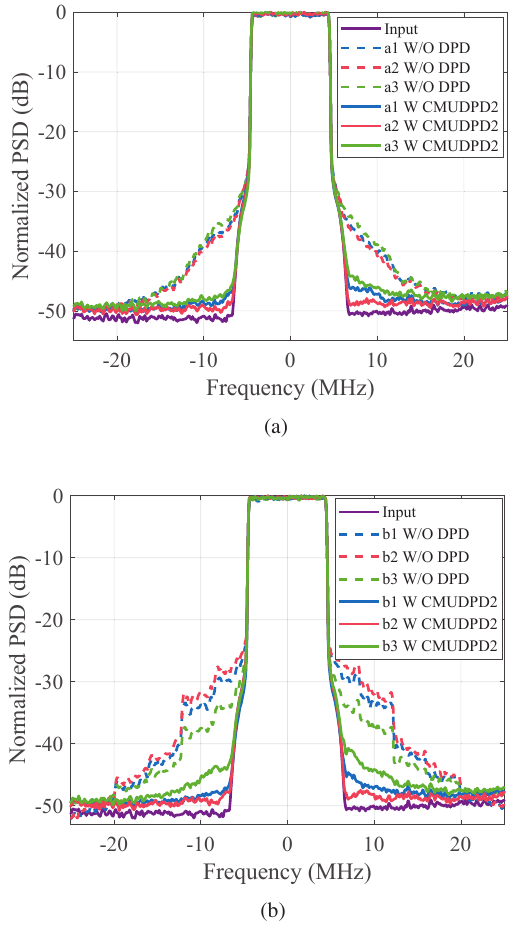
Figure 13. Experimental results of PSDs with (W) and without (W/O) CMUDPD2. ( a ) Group A: mode a1, a2, and a3 W and W/O CMUDPD2. ( b ) Group B: mode b1, b2, and b3 W and W/O